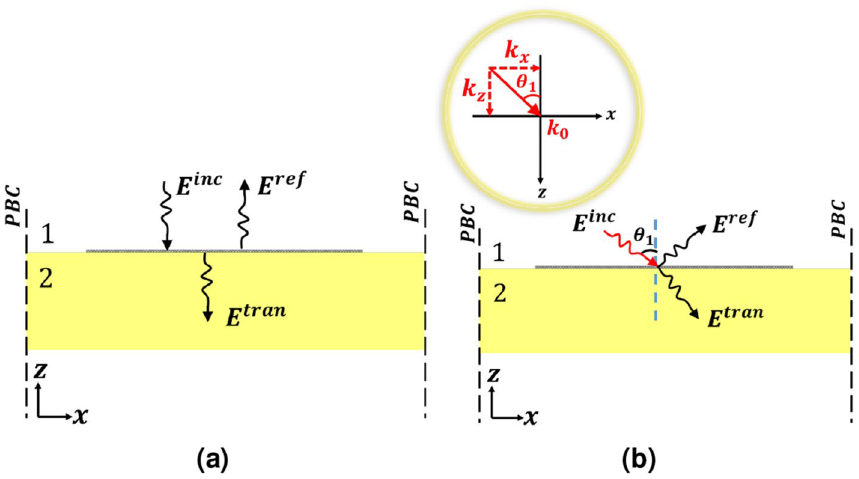
Figure 3. Plane wave incidence ( a ) Normal incidence ( b ) Oblique